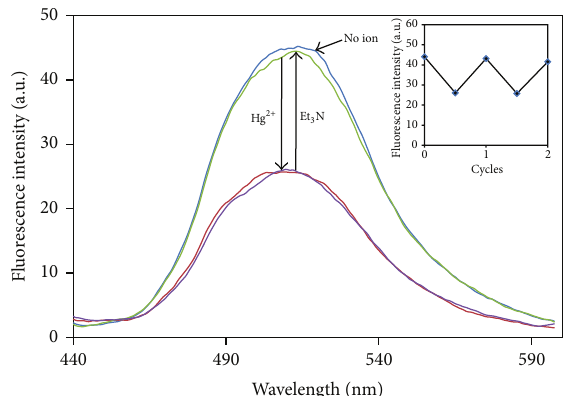
Figure 9: Fluorescence intensity before and after adding alternately Hg 2+ /Et 3 N into the solution of 1 (4.5 𝜇 M), with the different concentrations: 0/0, 0.7/0, 0.7/1.4, 1.4/1.4, and